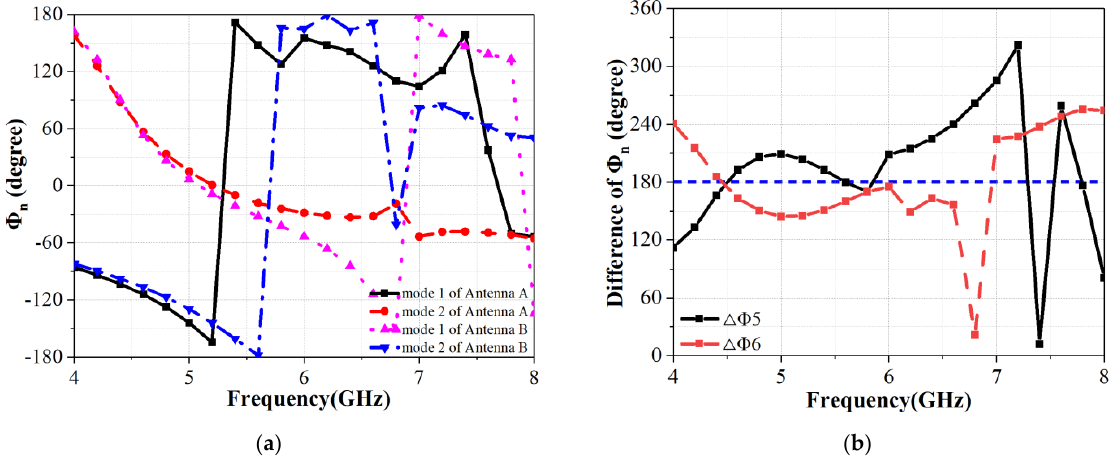
Figure 16. φ n and difference of φ n of the dominant scattering characteristic modes of the reference antenna and antenna A. ( a ) φ n of antenna A and antenna B; ( b ) difference of φ n of the dominant scattering characteristic modes of the reference antenna and antenna A.